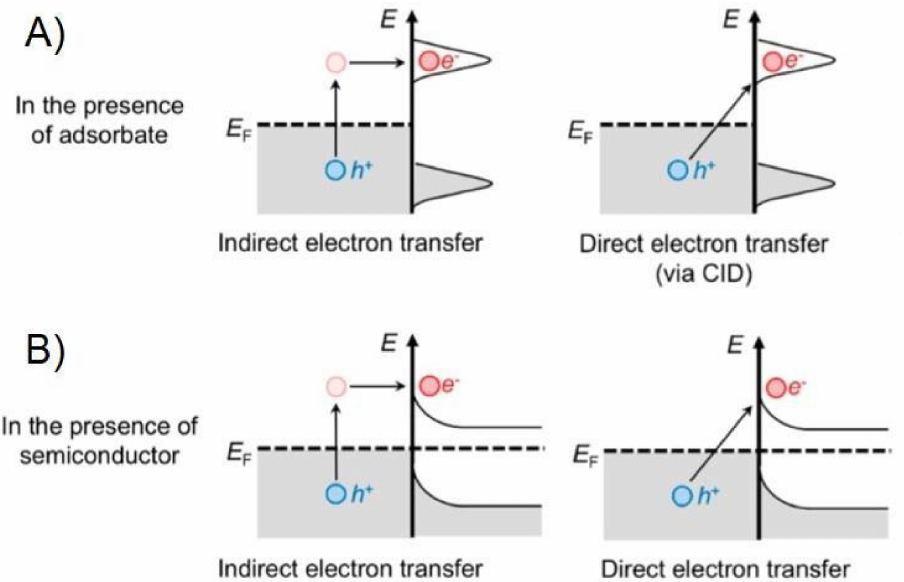
Figure 4. ( A ) When there is presence of adsorbate molecules on plasmonic NPs, the charge-carrier generation process through the LSPR decay can follow two main mechanisms of electron transfer into acceptor adsorbate molecules as depicted. ( B ) Similarly, the presence of a semiconductor material in contact with the plasmonic NPs will cause an interaction during the charge-carrier generation through the LSPR decay transferring hot electrons into the neighboring material as illustrated. ( A , B ) Adapted with permission from Zhang et al. Chem. Rev. 2018, 118, 6, 2927–2954, Copyright 2018, American Chemical Society